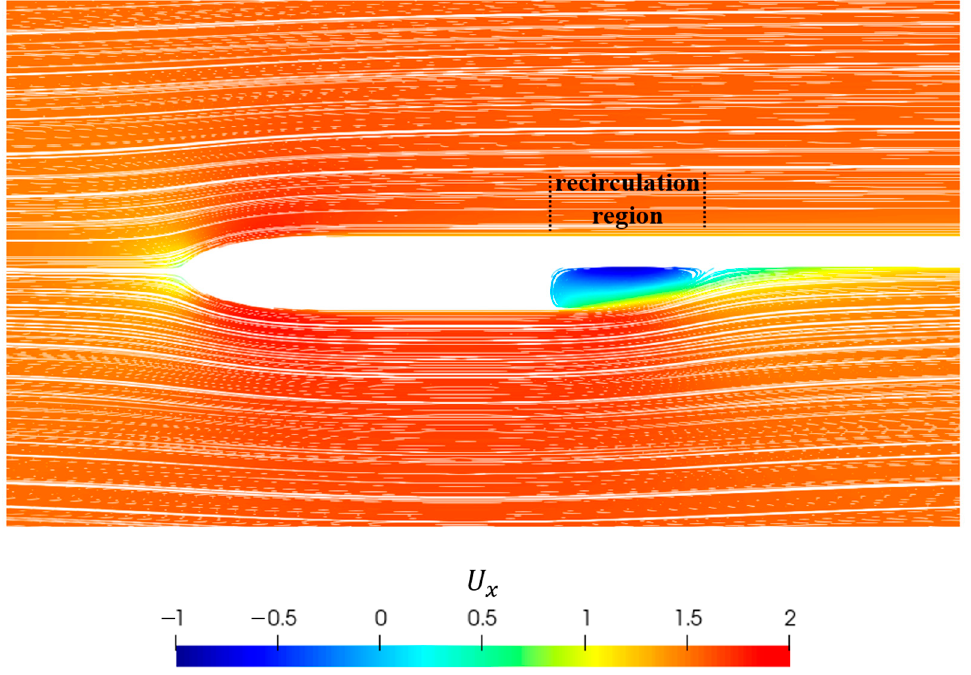
Figure 9. Side view of the flat plate recirculation area.